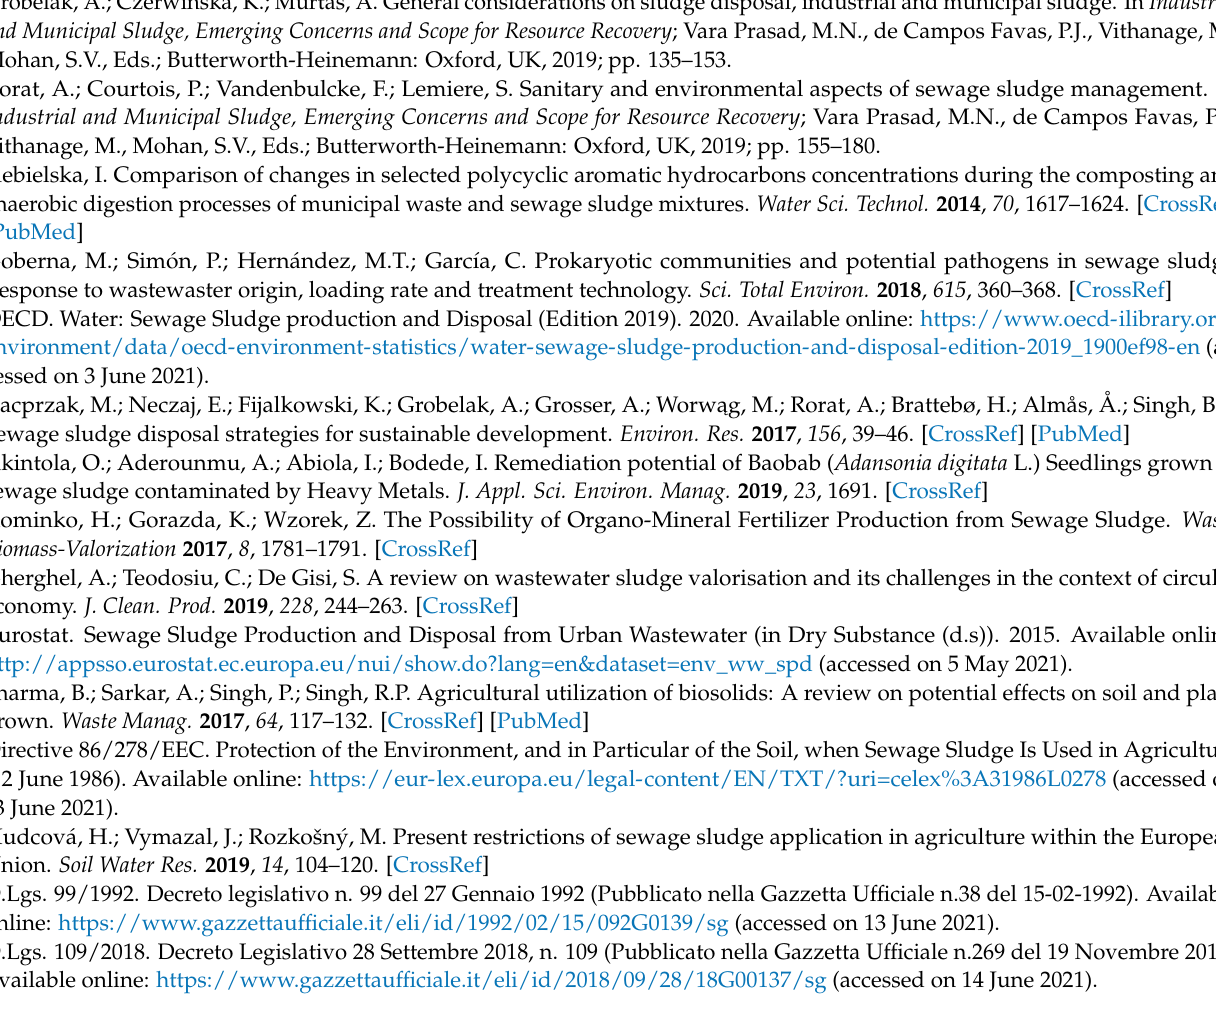
Figure S2: Crop species growing on sewage sludge after 2, 5, and 8 weeks. Table S1: Sewage sludge physico-chemical characteristics before phytoremediation. Table S2: Plant growth parameters and metal uptake. Table S3: Plant bioaccumulation and translocation factors. Table S4: Sewage sludge physico-chemical characteristics after